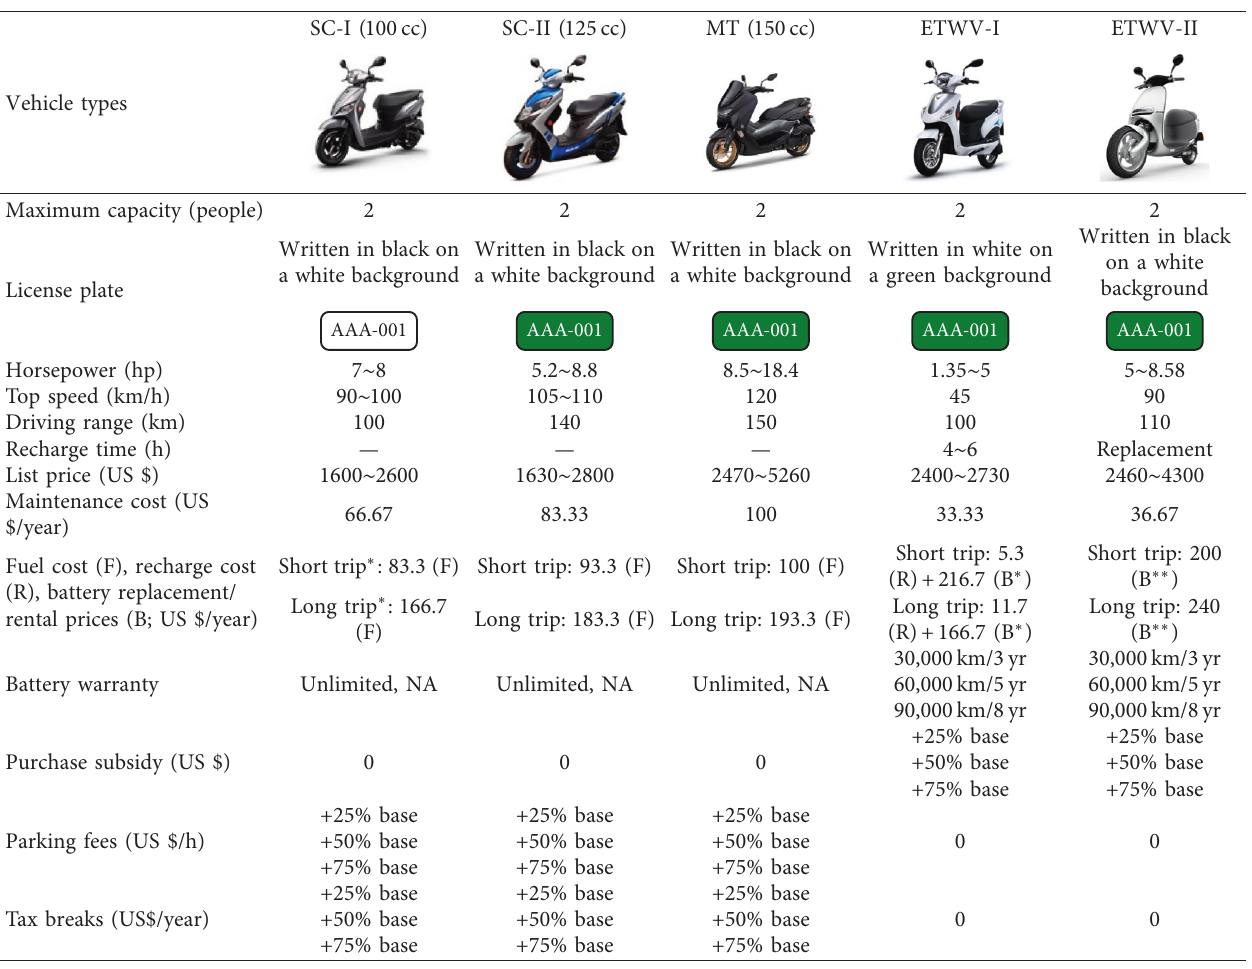
Table 2: Attributes’ values and levels for five different vehicle